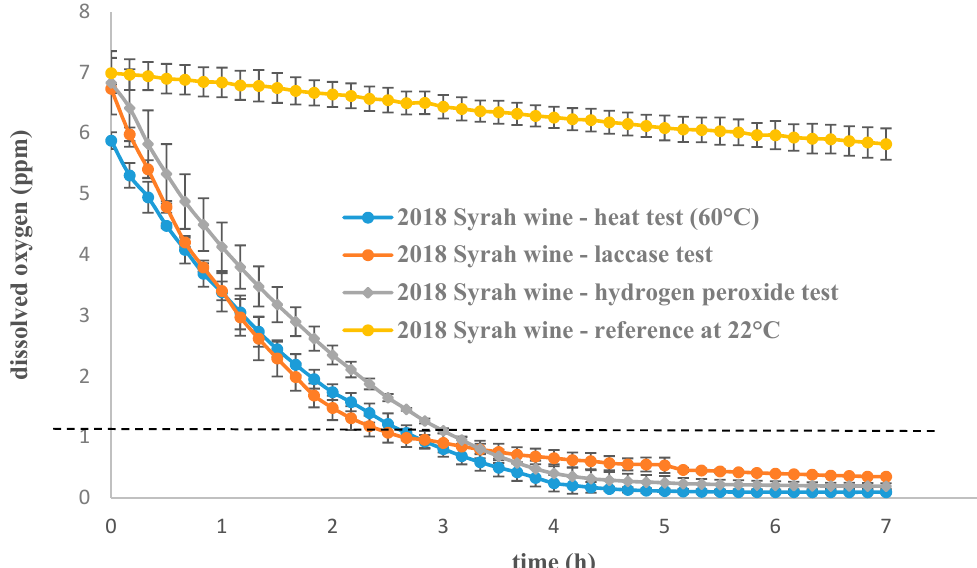
Figure 1. Rate of dissolved oxygen consumption in three di ff erent ageing tests used on a 2018 red wine sample (average, n = 3 or 4, and standard deviation for each point). Data are available in supplementary data: Tables S4–S7.